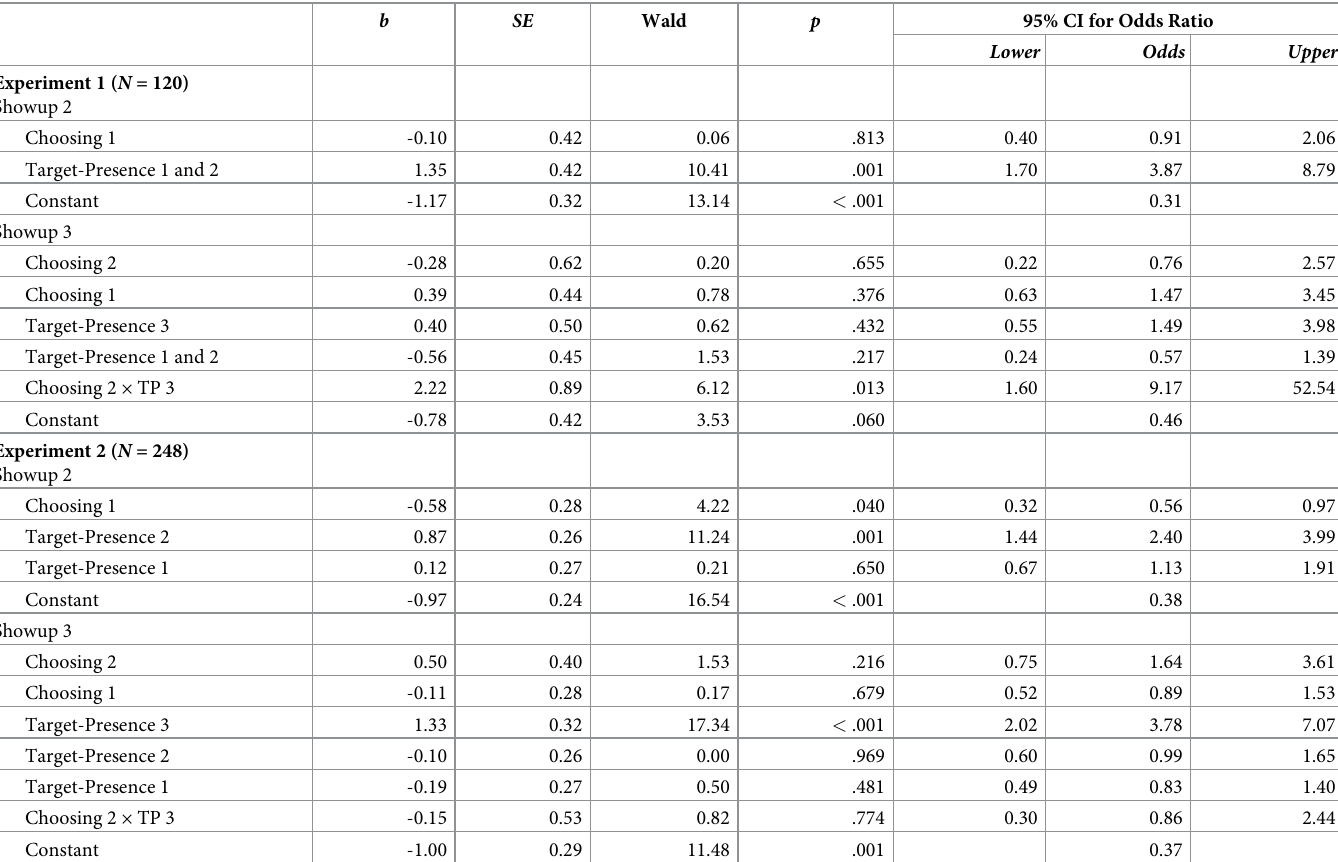
Table 2. Experiments 1 and 2: Complete models of logistic regressions predicting choosing on showups 2 and 3 based on previous choosing and